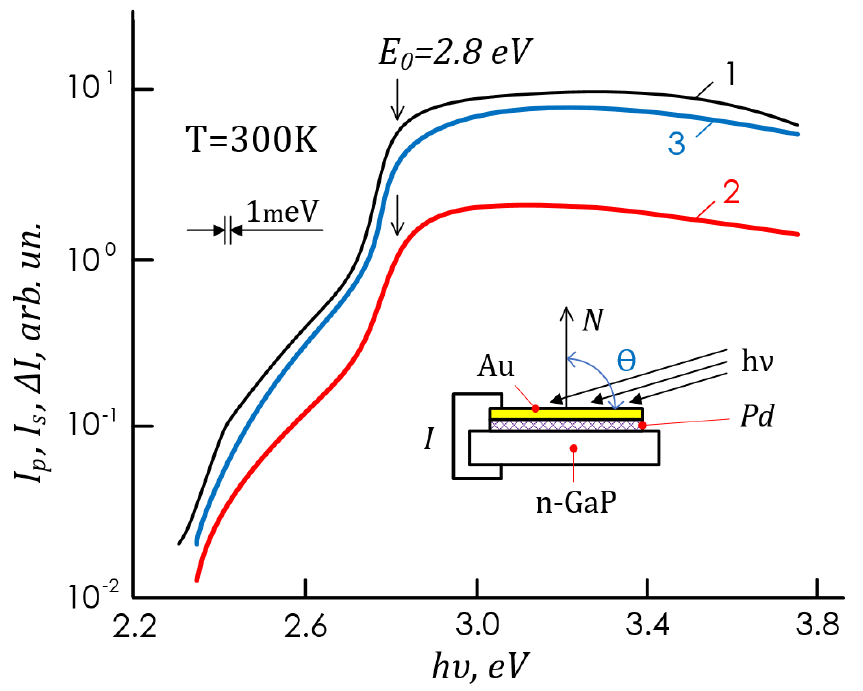
Figure 10. Spectral dependences of short-circuit photocurrent I ‖ (1), photocurrent polarization difference (2), short-circuit photocurrent I ⊥ (3), for surface-barrier structures (Sample No. 5). The inset shows the scheme of the experiment, Ө = 80°.